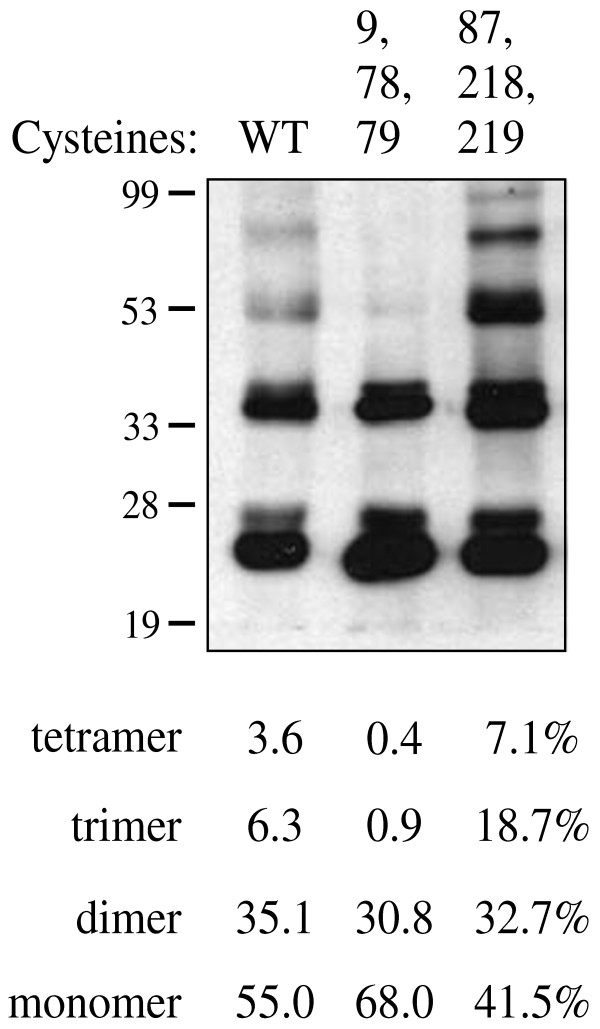
CD9 cross-linking through N- or C-terminal cysteine residues. RD cells were transfected with constructs encoding wild-type CD9 protein, CD9 containing only the three N-terminal cysteines (Cys9, 78 and 79), or the three C-terminal cysteines (Cys87, 218 and 219). Cells were treated with 2-BP for 16 hours and lysed in buffer containing 1% Brij97 for spontaneous disulfide cross-linking. Cell lysates were analyzed by CD9 Western. Relative intensity of bands corresponding to CD9 monomers, dimers, trimers and tetramers was calculated as a percent fraction of total protein material (monomers through tetramers).